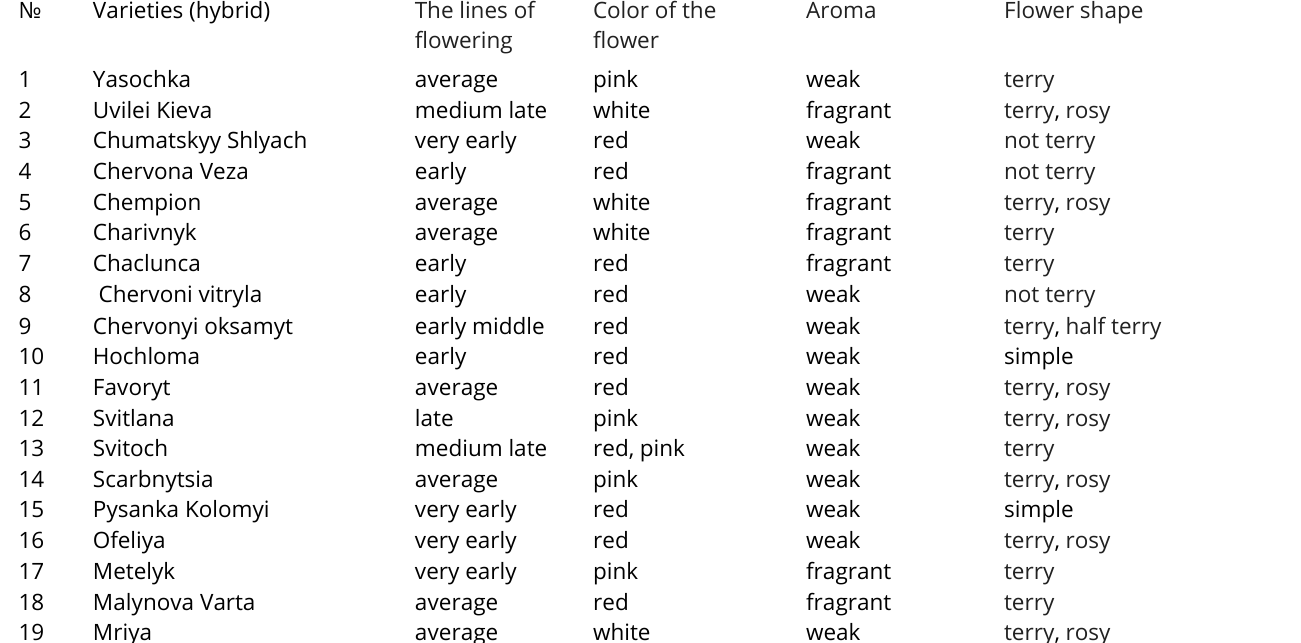
ISSN 2412-1908; http://journal.asu.ru/biol/